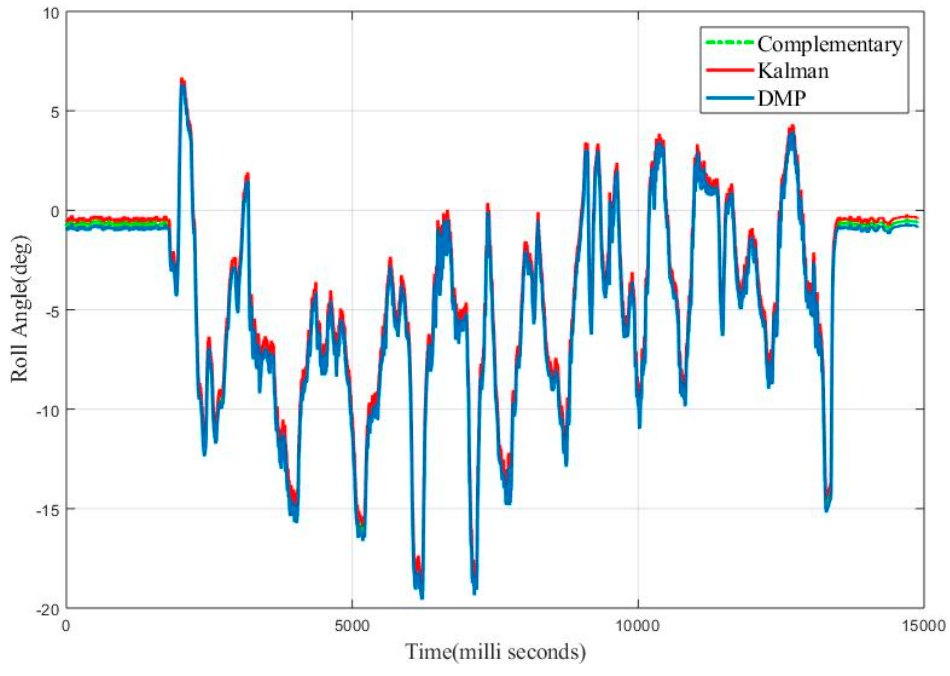
Figure 31. Real Time Roll Angle Estimate for Complementary and Kalman Filter.